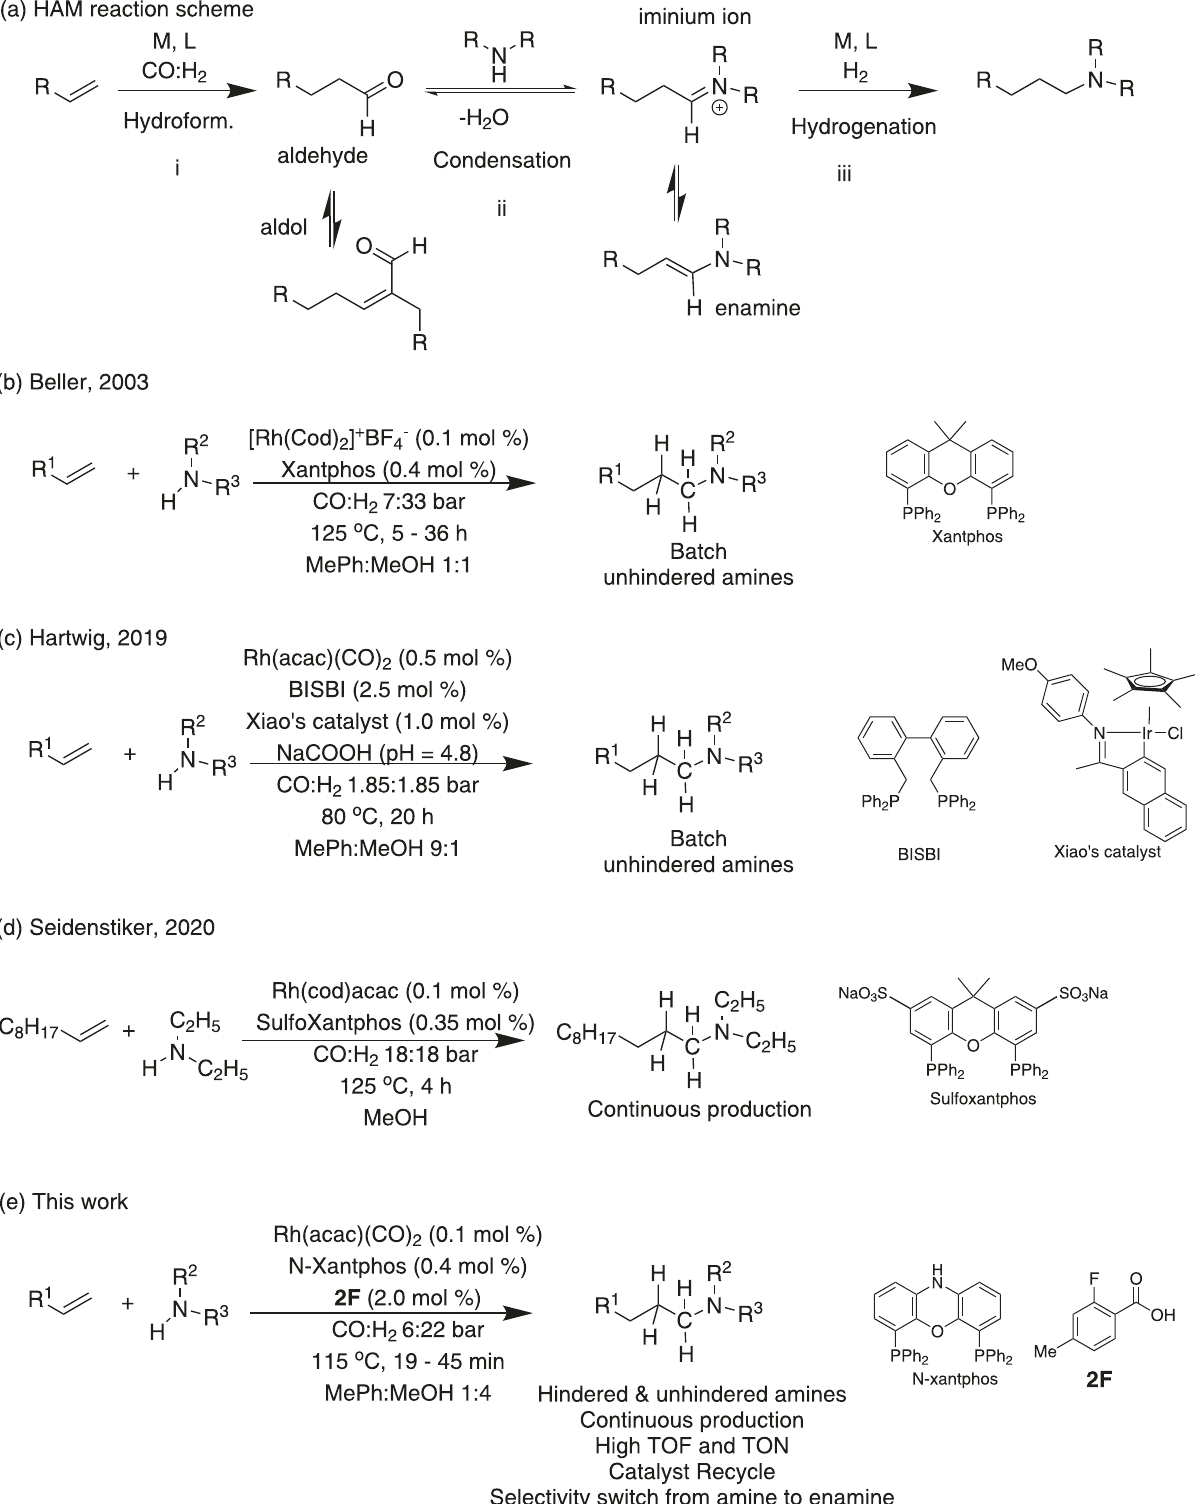
Fig. 1 HAM reaction scheme and a summary of prior HAM work vs. this work. a Amine formation by tandem hydroformylation-condensation- hydrogenation reactions. M: metal, L: ligand. b – e Different approaches to amine syntheses via HAM reaction.